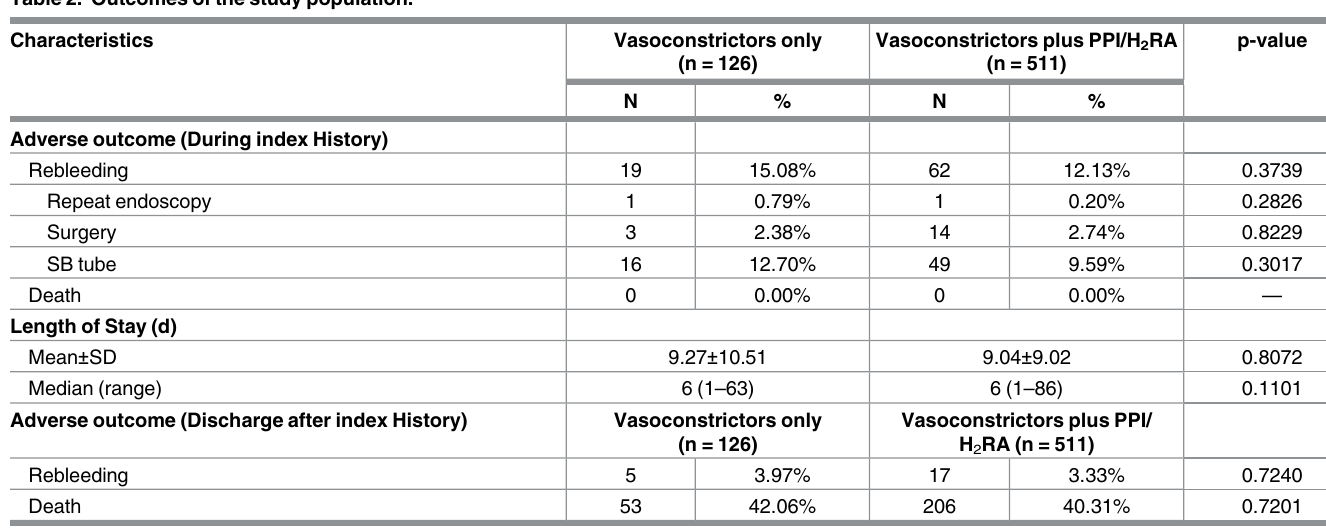
Table 2. Outcomes of the study population.